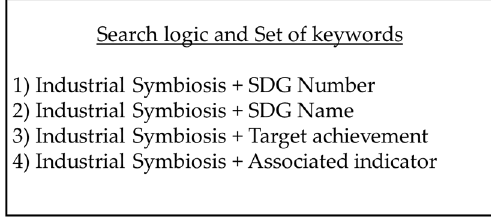
Figure 1. Logic and Set of keywords used in the research.